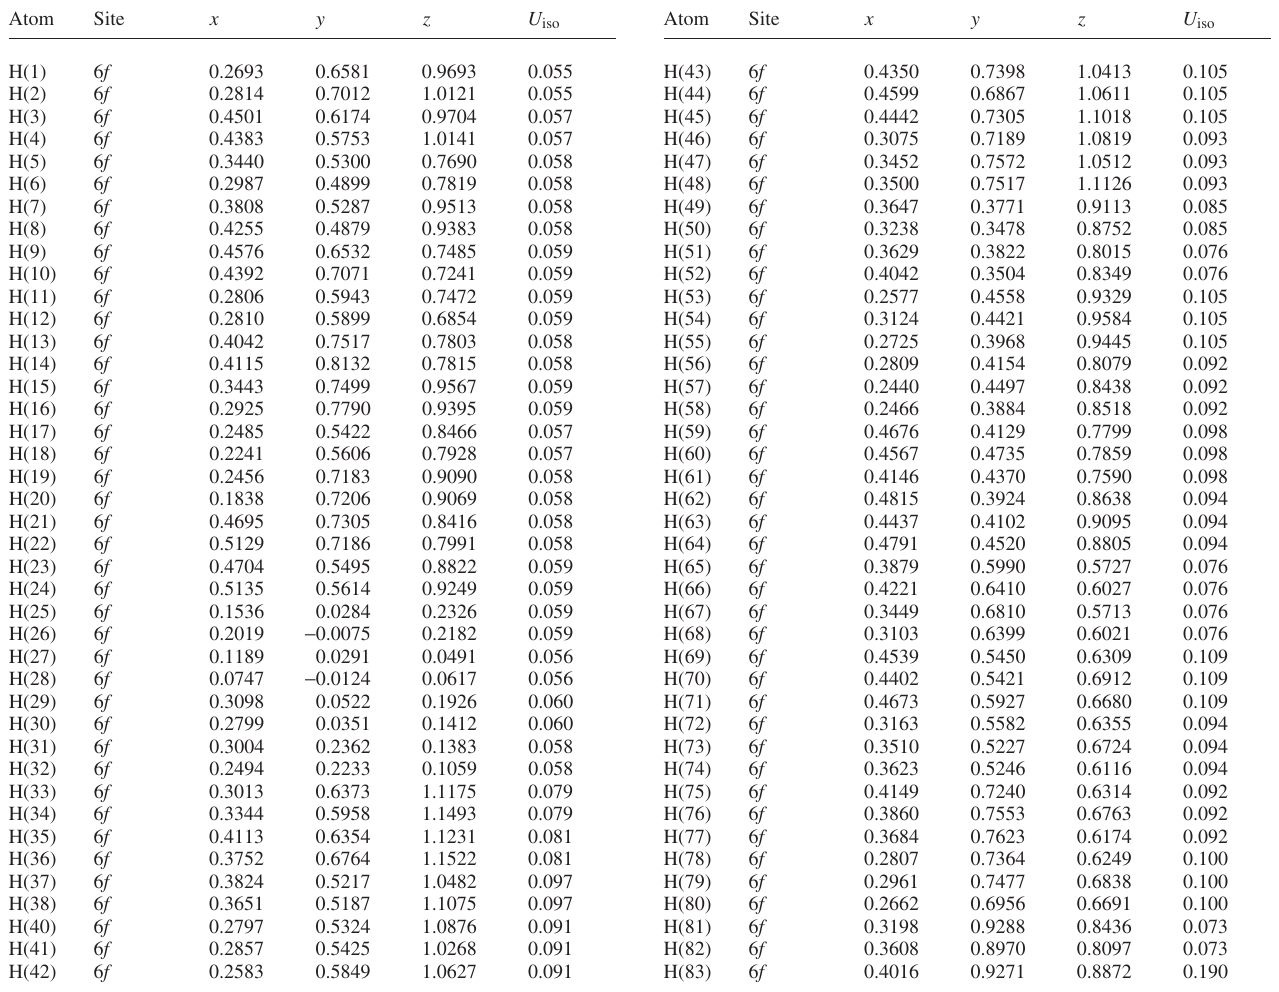
Table 2. Atomic coordinates and displacement parameters (in Å 2 ) .